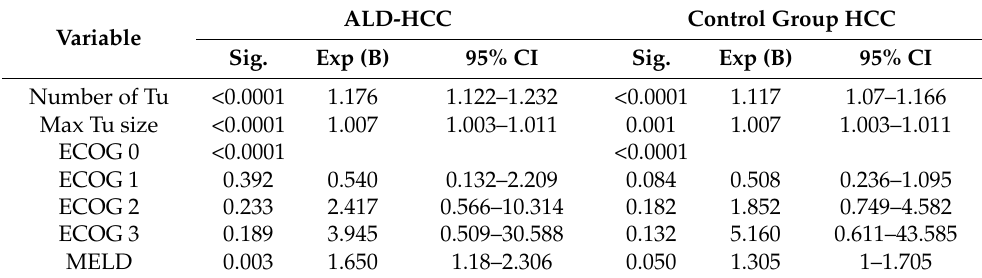
Table 6. Analysis of tumor characteristics, performance status and MELD in both studied groups.